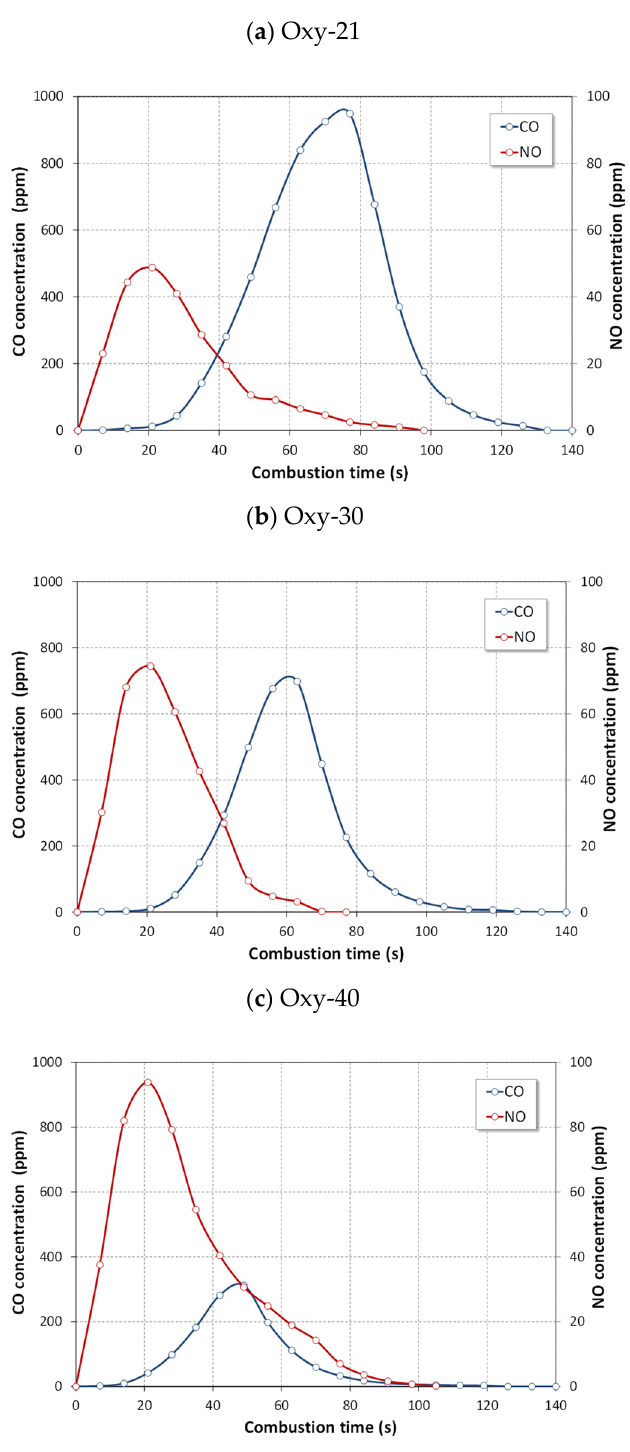
Figure 19. NO and CO (ppm) profiles during combustion of wheat straw under oxy-combustion.